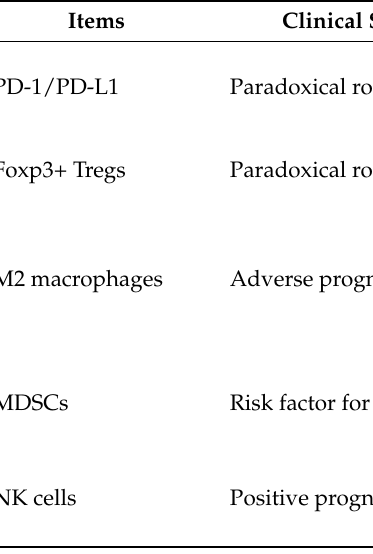
Table 1. Clinical significance and involved mechanisms of immune cells and